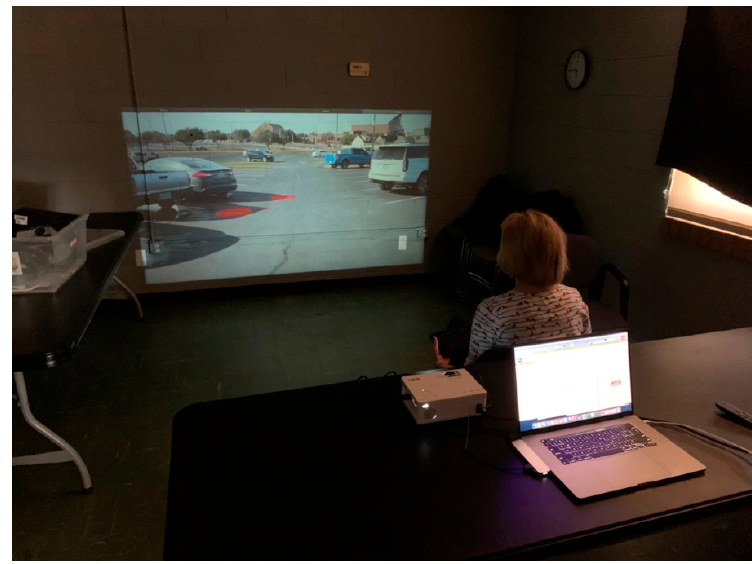
Figure 7. Experiment room in Pittsfield Senior Center.